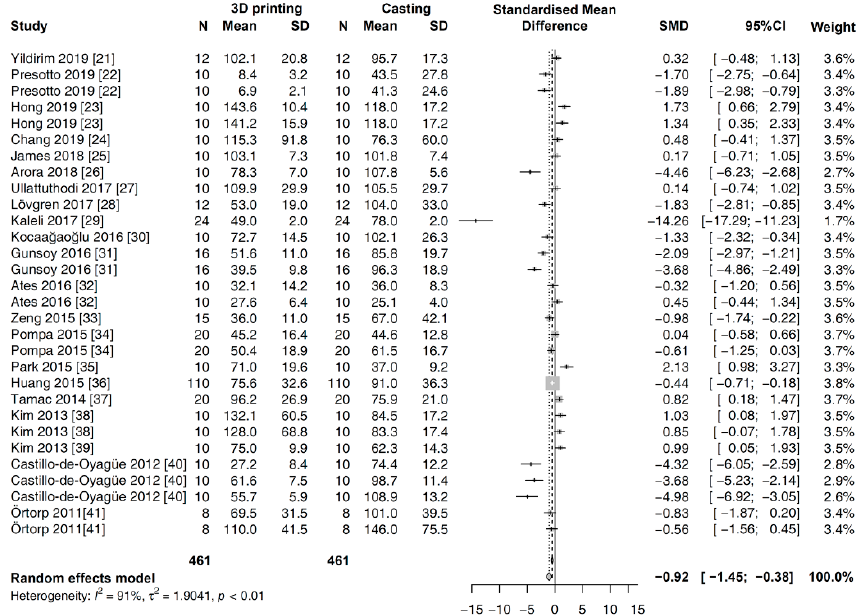
Figure 4. Subgroup meta-analysis for the different prosthesis types on the marginal gap between 3D printing and casting methods.